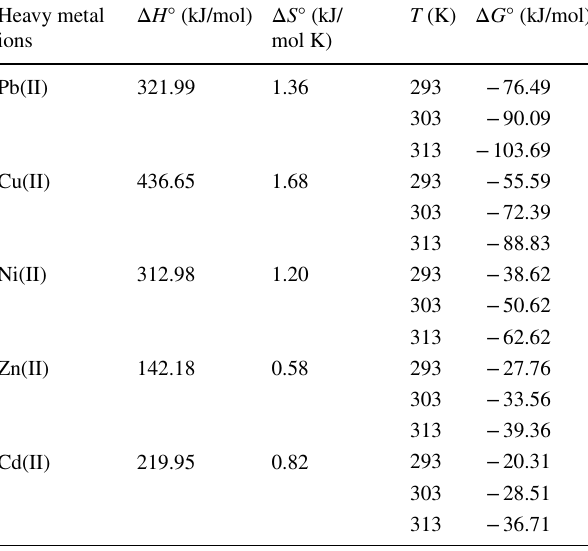
Table 4 The thermodynamic parameters for the biosorption of heavy metals onto Posidonia